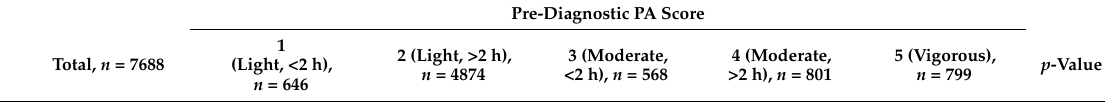
Table 1. Characteristics of SGBCC study population by pre-diagnostic physical activity (PA) score ( n = 7688). p -value ( p ) for categorical variables are based on Chi-square test and p -value for continuous variables are based on Kruskal-Wallis